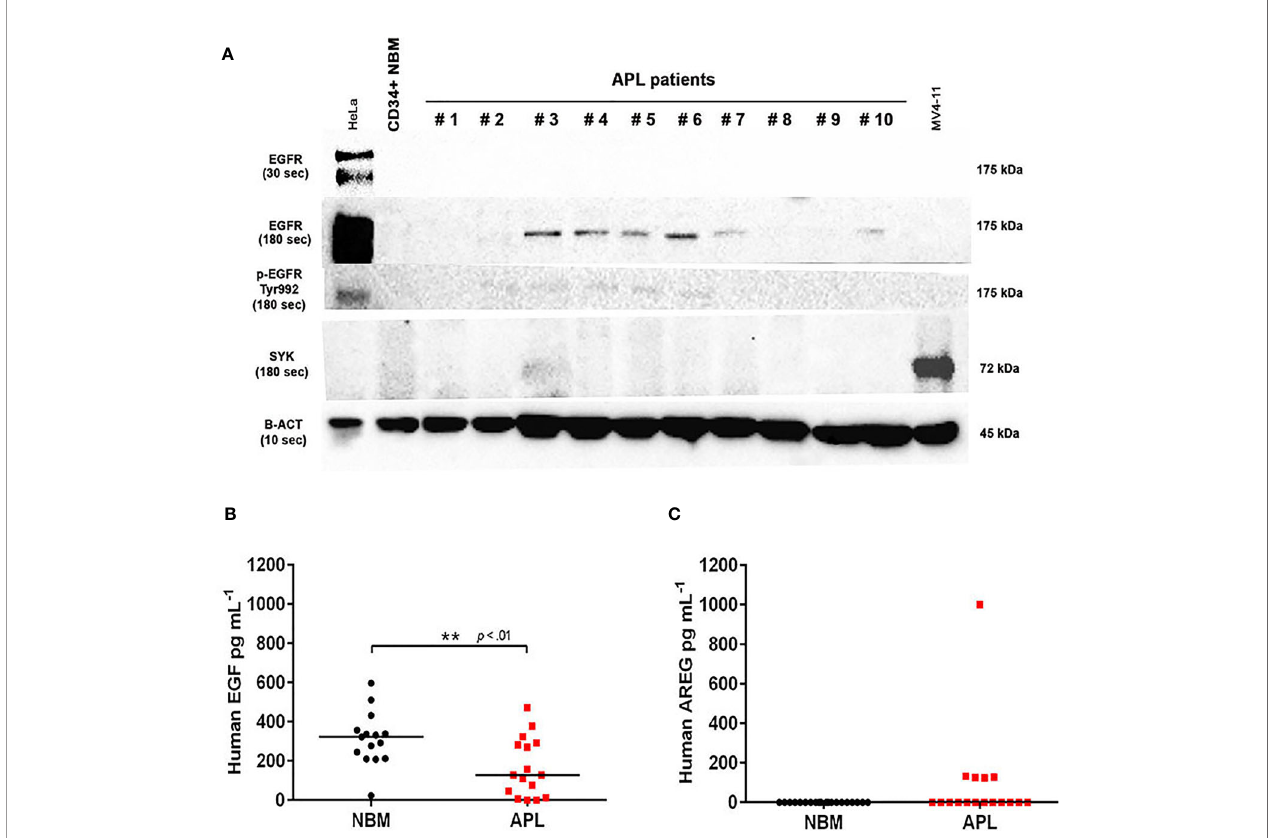
FIGURE 1 | EGFR, p-EGFR (Tyr992), SYK, EGF, and AREG protein expression in APL patient samples. (A) Western blotting analysis of EGFR, p-EGFR (Tyr992), SYK, and b -actin protein levels in CD34 + cells isolated from normal BM of one healthy adult volunteer and 10 representative primary APL samples collected at diagnosis. HeLa cells served as a positive control to assess EGFR and p-EGFR (Tyr992) expression, and MV4-11 cell extracts were used as a positive control for SYK expression. EGFR and p-EGFR (Tyr992) were detectable when exposed for 180 seconds (sec). (B) EGF levels in BM plasma samples from healthy donors (n=15) and APL patients at diagnosis (n=16). (C) Plasma AREG levels in BM from healthy donors (n=20) and APL patients at diagnosis (n=17). (**) p < 0.01 (Mann- Whitney U-test).